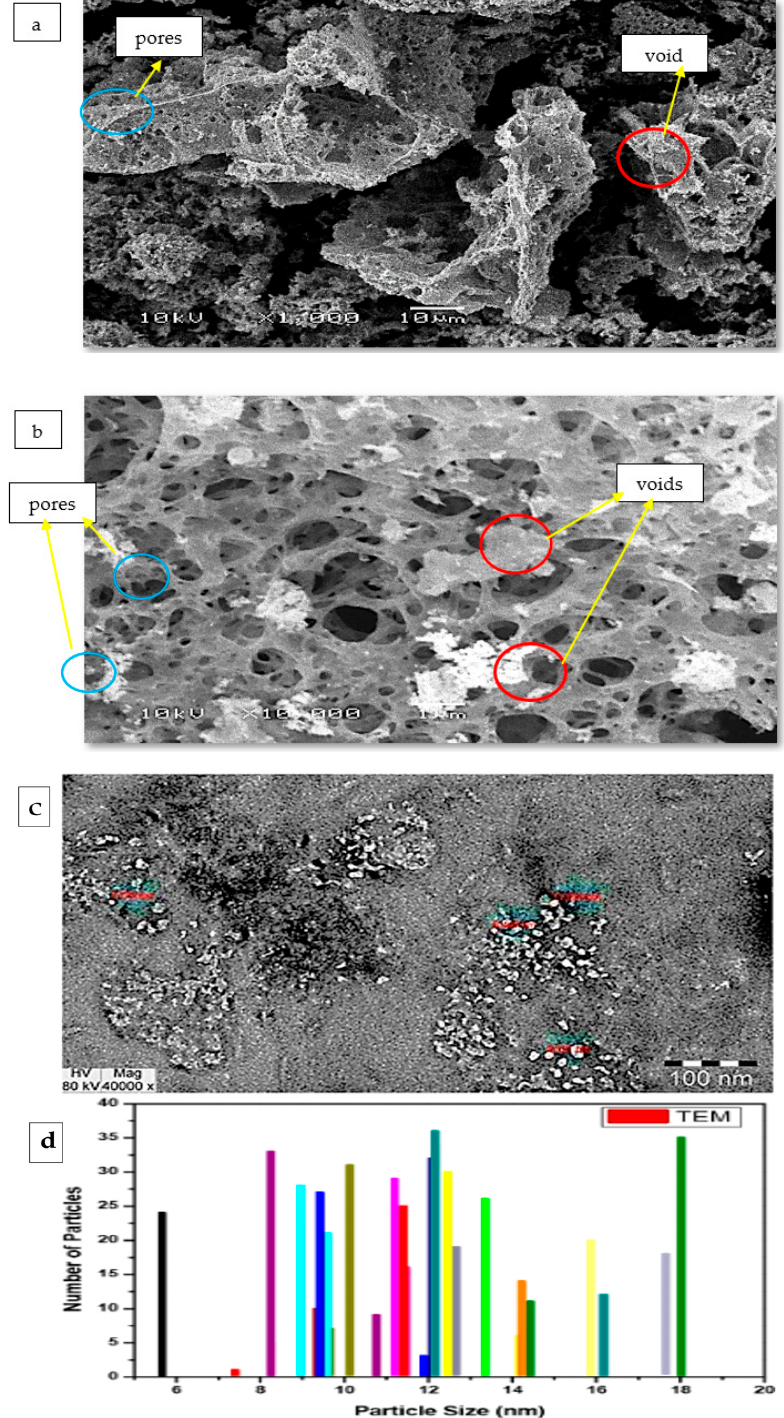
Figure 1. ( a , b ) SEM image of the as-prepared CoO/Co 3 O 4 NPs with 1000 × and 10,000 ×